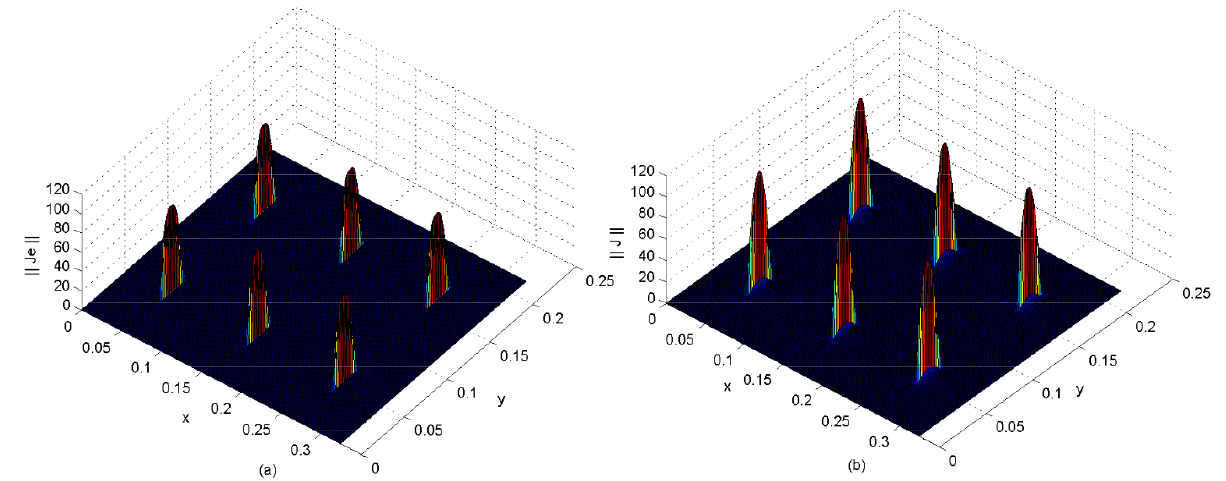
Figure 10. Current density of an example of almost periodic 2D array (half-wave dipoles) defined by the guide wave aperture, described by ( a ) test functions or ( b ) basis functions (guide modes) at the operating frequency (f) of 5.4 GHz. The physical parameters used were: α 0 = 0 rad m − 1 , β 0 = 0 rad m − 1 , w = 1 mm, δ = 0.75 mm ( w (cid:28) λ 0 , δ (cid:28) λ 0 ) , d x = 108 mm, d y = 108 mm, L = λ 0 27 mm, h = 1.25 mm, and (cid:101) = (cid:101) r = 1 (air) (see [1] for a